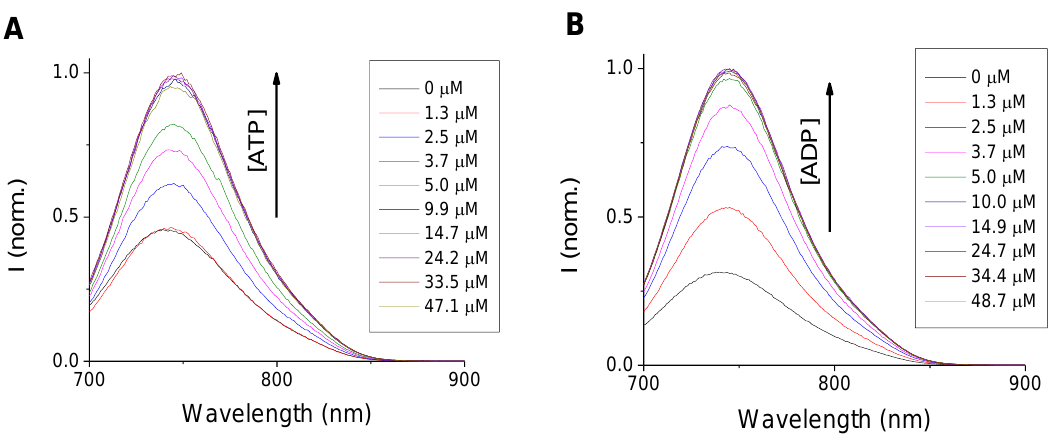
Figure 10. Emission spectra of 1 -Zn 2+ with increasing concentration of ( A ) ATP and ( B ) ADP. Conditions: MeOH:MOPS 10 mM pH7 (50:50); λ exc = 680 nm.